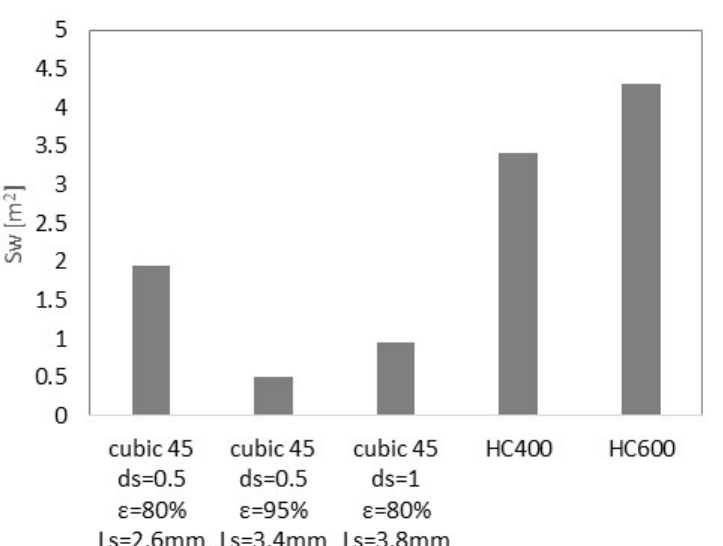
Figure 2. Wetted surface area (S w ) by the gas flow of three additively manufactured structures based on a rotated cube elementary cell (cubic 45) for different struts diameter (ds), porosities ( ε ), and cell size (Ls) in comparison with two state-of-the-art honeycombs (HC) with different cpsi (i.e., 400 and 600). Data source [16].